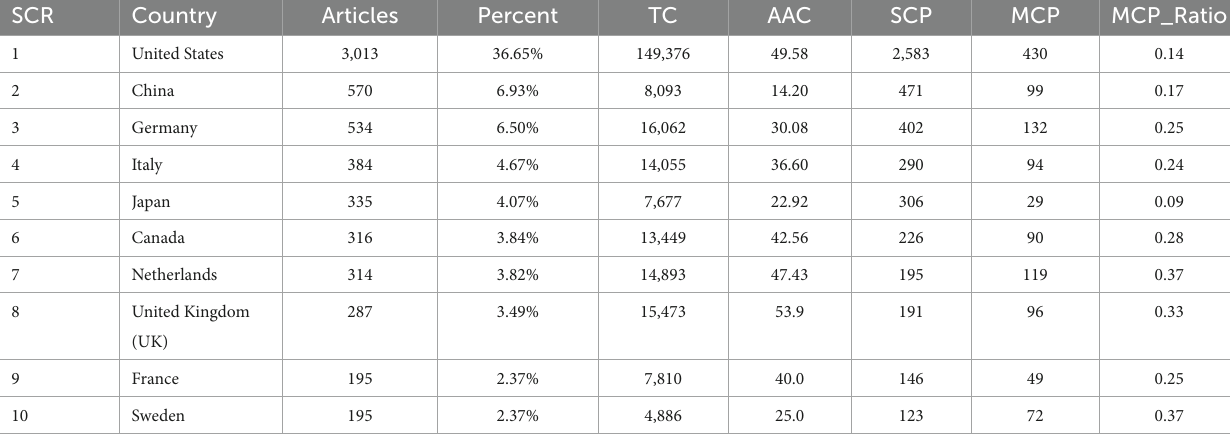
TABLE 1 Top 10 most productive countries on research related to heart failure and depression.